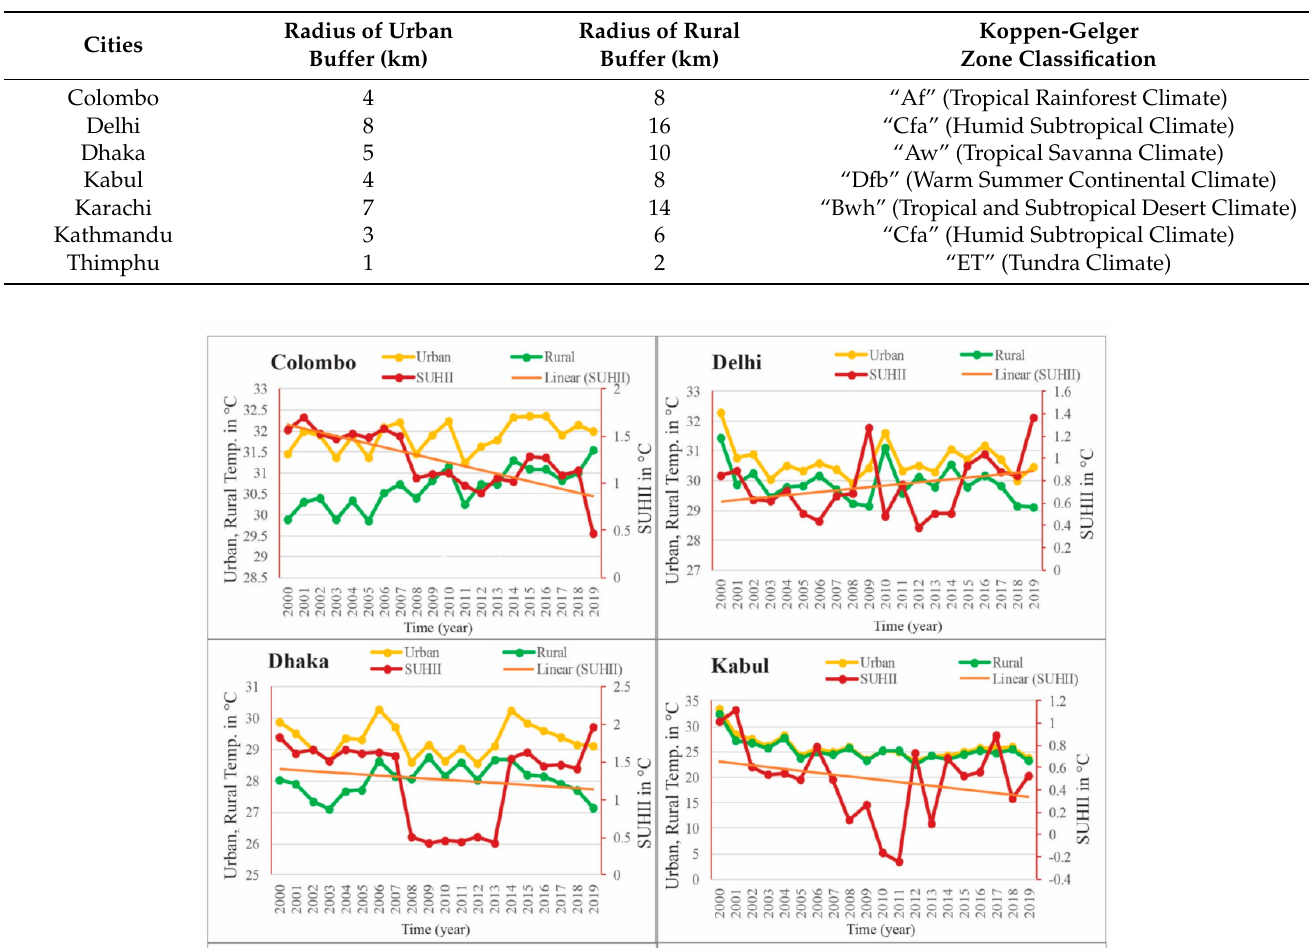
Table 5. SA Cities radii for Urban & Rural Buffers.